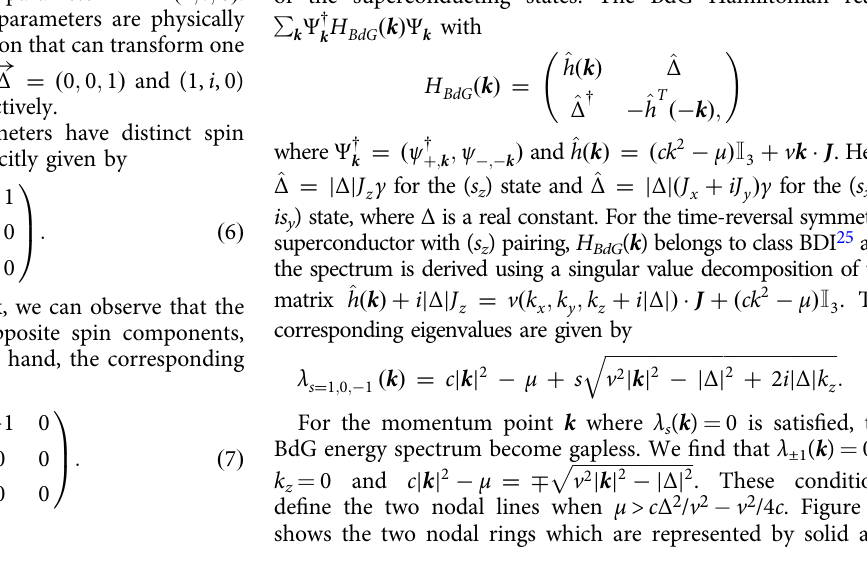
Fig. 1 Phase diagram of s -wave spin-triplet pairings. Within the leading one-loop calculation, triple point semimetals selectively stabilize two distinct paired states, depending on μ / T and v = symmetry broken state with ( s x + is y ) pairing (green) and time-reversal symmetric state with ( s z ) pairing (blue). μ , T , and v indicate chemical potential, temperature, and effective linear velocity of the band